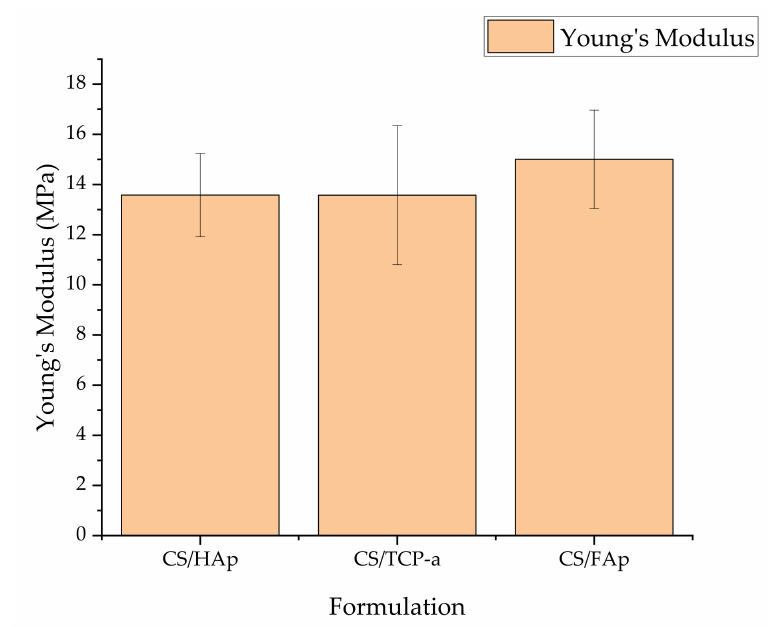
Figure 5. The compressive strength of the chitosan scaffolds with different bioceramics recorded similar values achieving a strength above 12 MPa.